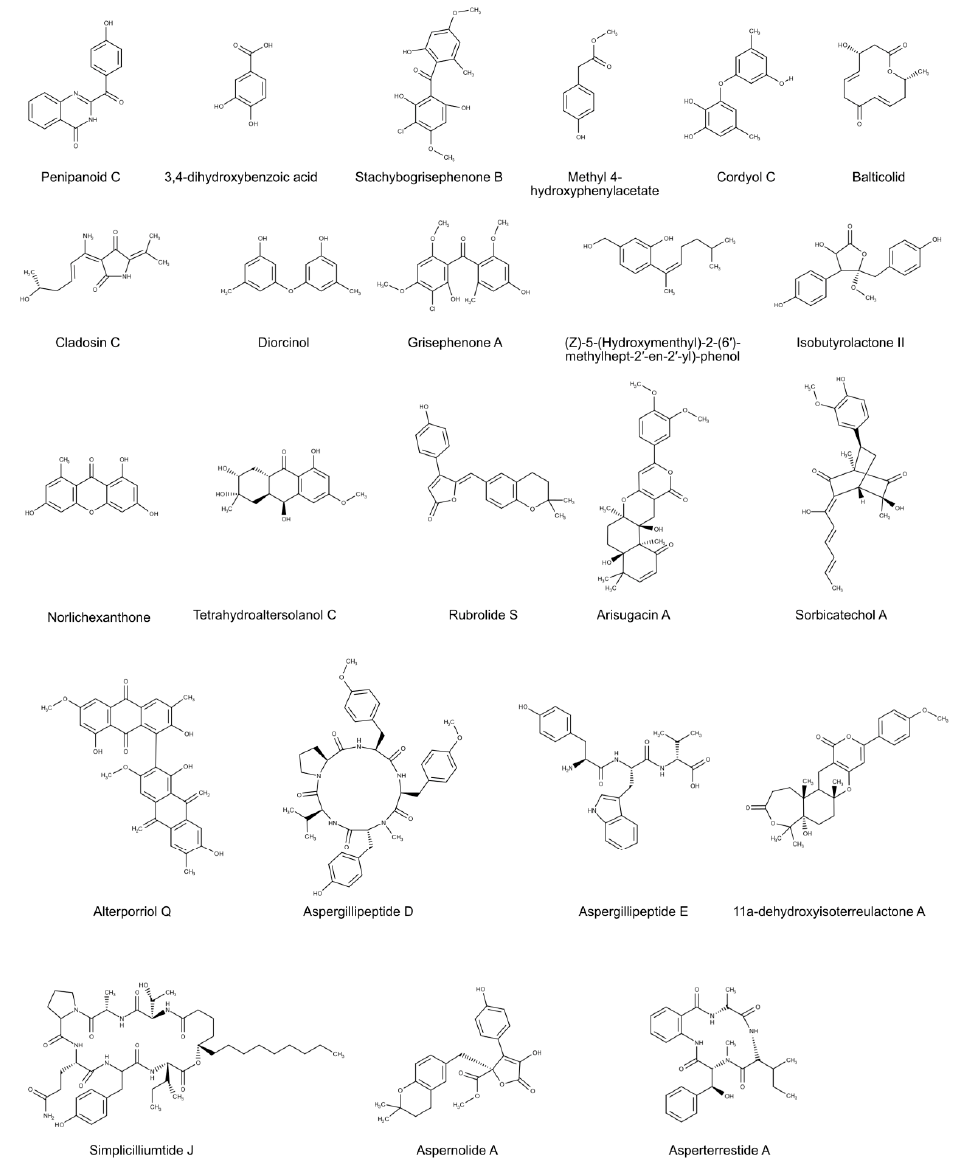
Figure 2. Structures of compounds isolated from marine fungi with antiviral